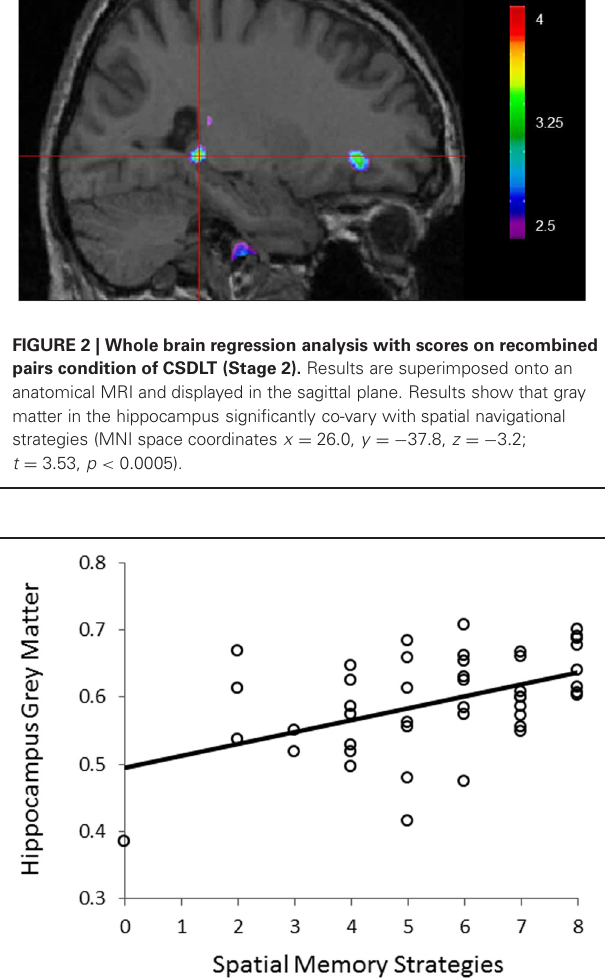
( Figure 4 ). Consistent with our earlier findings (Bohbot et